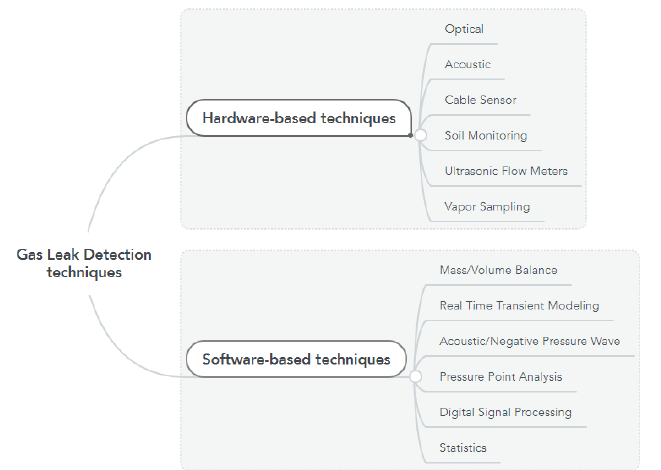
Figure 1. The categories of gas leak detection approaches and their